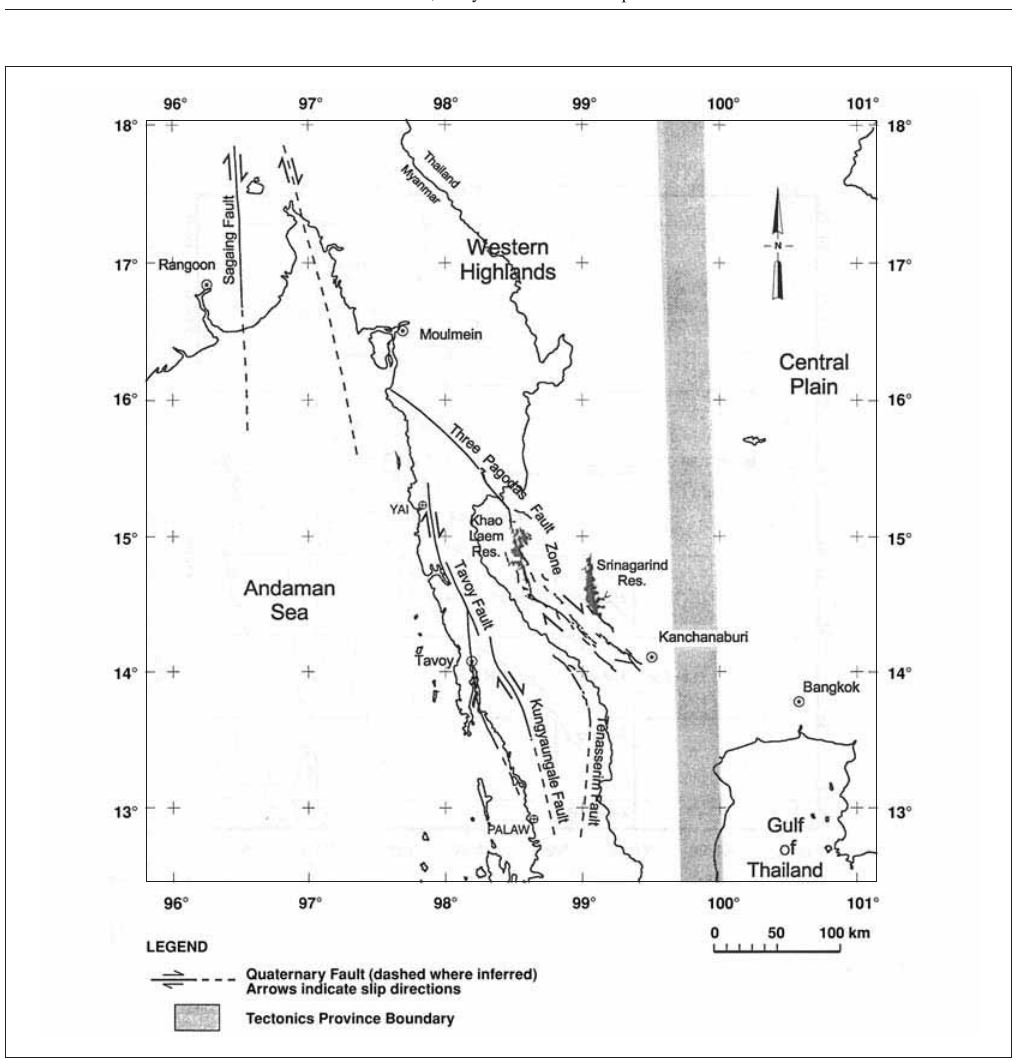
Fig. 15. Active faults in Western Thailand and